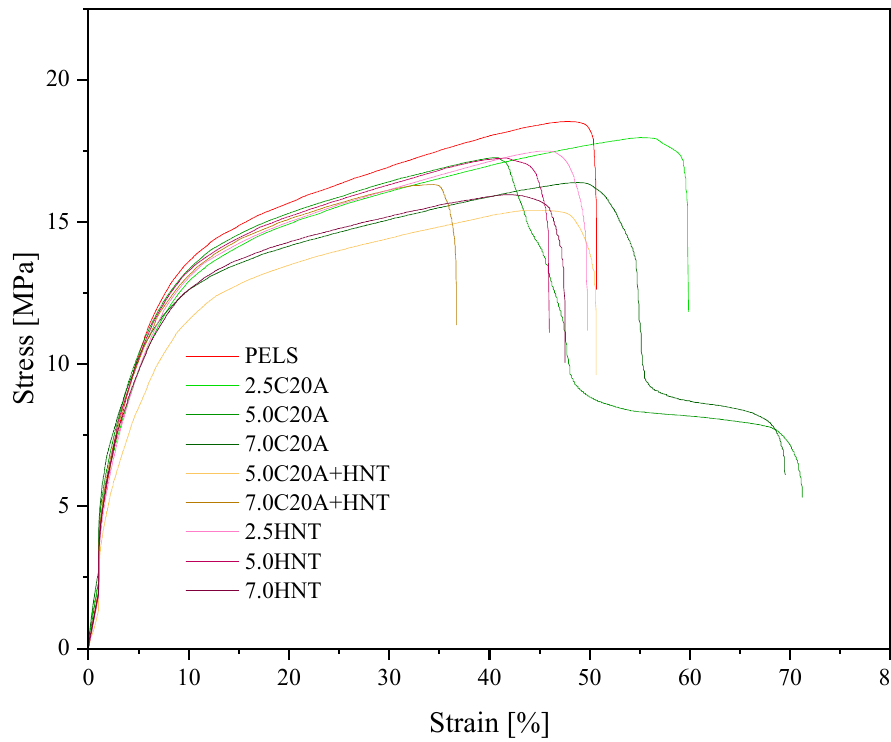
Figure 9. Representative stress–strain curves for the series of nanocomposites based on PELS.